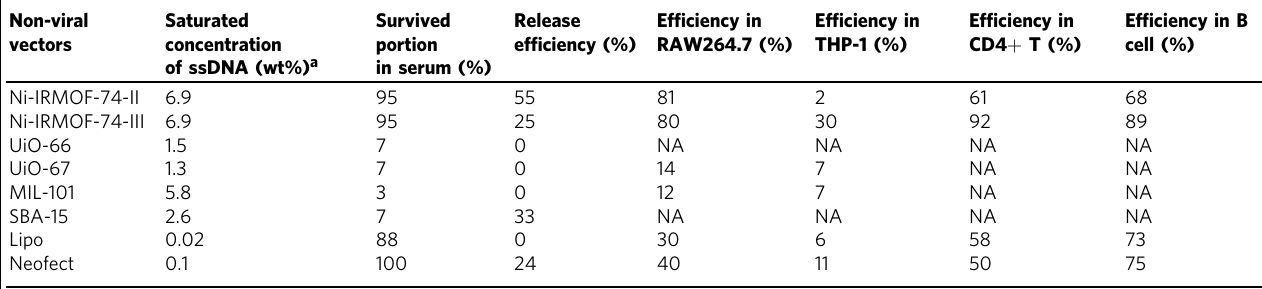
Table 1 Summary of the in vitro tests and transfection ef fi ciency in cells using different vector materials Non-viral Saturated vectors concentration of ssDNA (wt%)